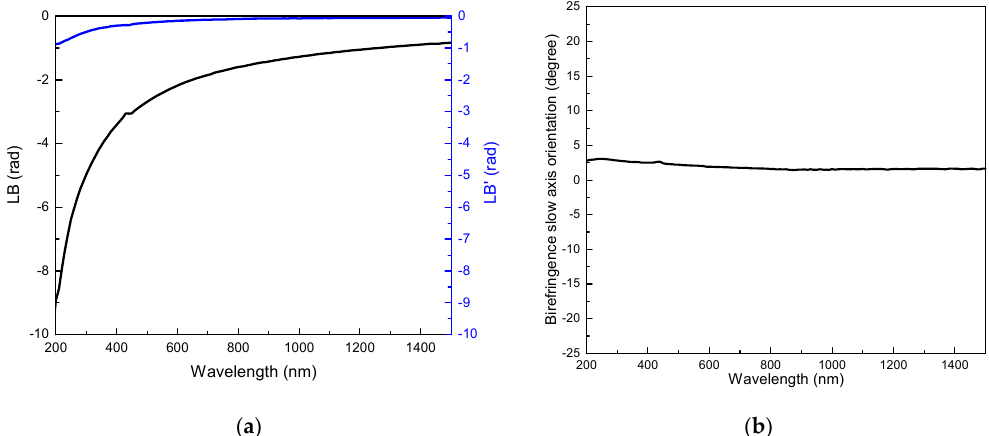
Figure 2. Experimental values of effective linear anisotropic optical properties for 1 mm clear aperture stress waveplate: ( a ) Linear birefringences LB and LB’ (defined in text). ( b ) Slow axis orientation (in degree) of the linear birefringence as a function of the wavelength. Waveplate design: stressor gap Δ y = 5 µm, 100 stressors per bar, 10 layers with Δ z = 50 µm.